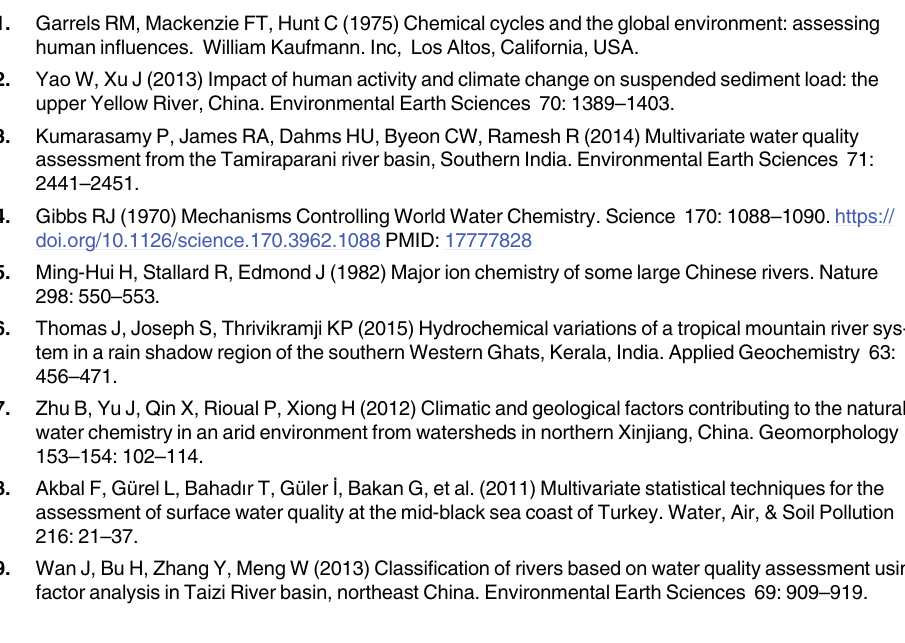
S1 Table. Statistics of water quality and stable isotope in surface water of the Bamen Bay basin. S2 Table. Pearson correlation among ORP, DO, NH